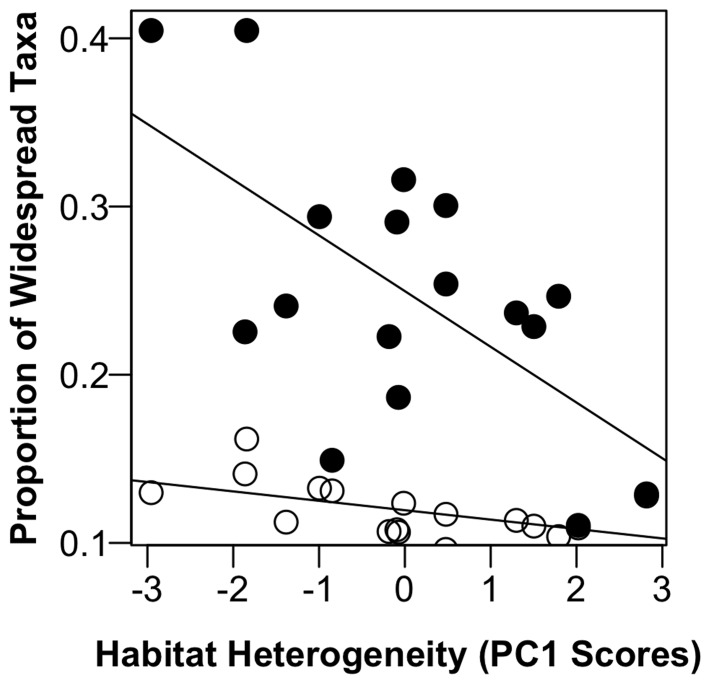
Relationship of habitat heterogeneity with the proportional representation of widespread taxa in each lake.Heterogeneity was measured as the PC 1 scores of ‘heterogeneity’ model. Filled circles show the total proportion of relative abundance made up by widespread taxa (R2 = 0.35, p = 0.007) and open circles show widespread taxa as a proportion of the total number of taxa observed (R2 = 0.23, p = 0.03).